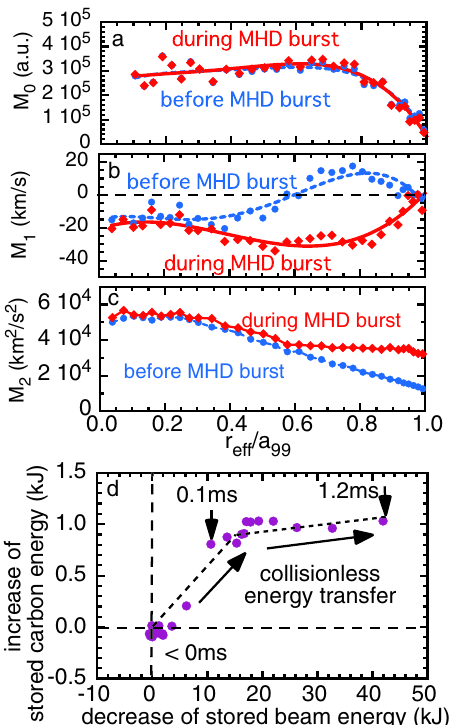
Fig. 4 Collisionless energy transfer to carbon impurity ions. Radial pro fi les of a 0th moment, b 1st moment, c 2nd moment of ion velocity distribution function of carbon impurity ions before (blue circles and lines) and during MHD (magnetohydrodynamics) burst (red circles and lines) and d relation between the increase of stored carbon energy and decrease of stored energy (#164992, #165851, #165859, #165862, #165863, #165943, #165971, #165977). magnetic fi eld perturbation and the plasma displacement at a = 0.83 show a solitary wave feature with only one cycle. r eff / 99 There is residual oscillation with small amplitude in the magnetic fi eld perturbation but not in the plasma displacement. The fre-